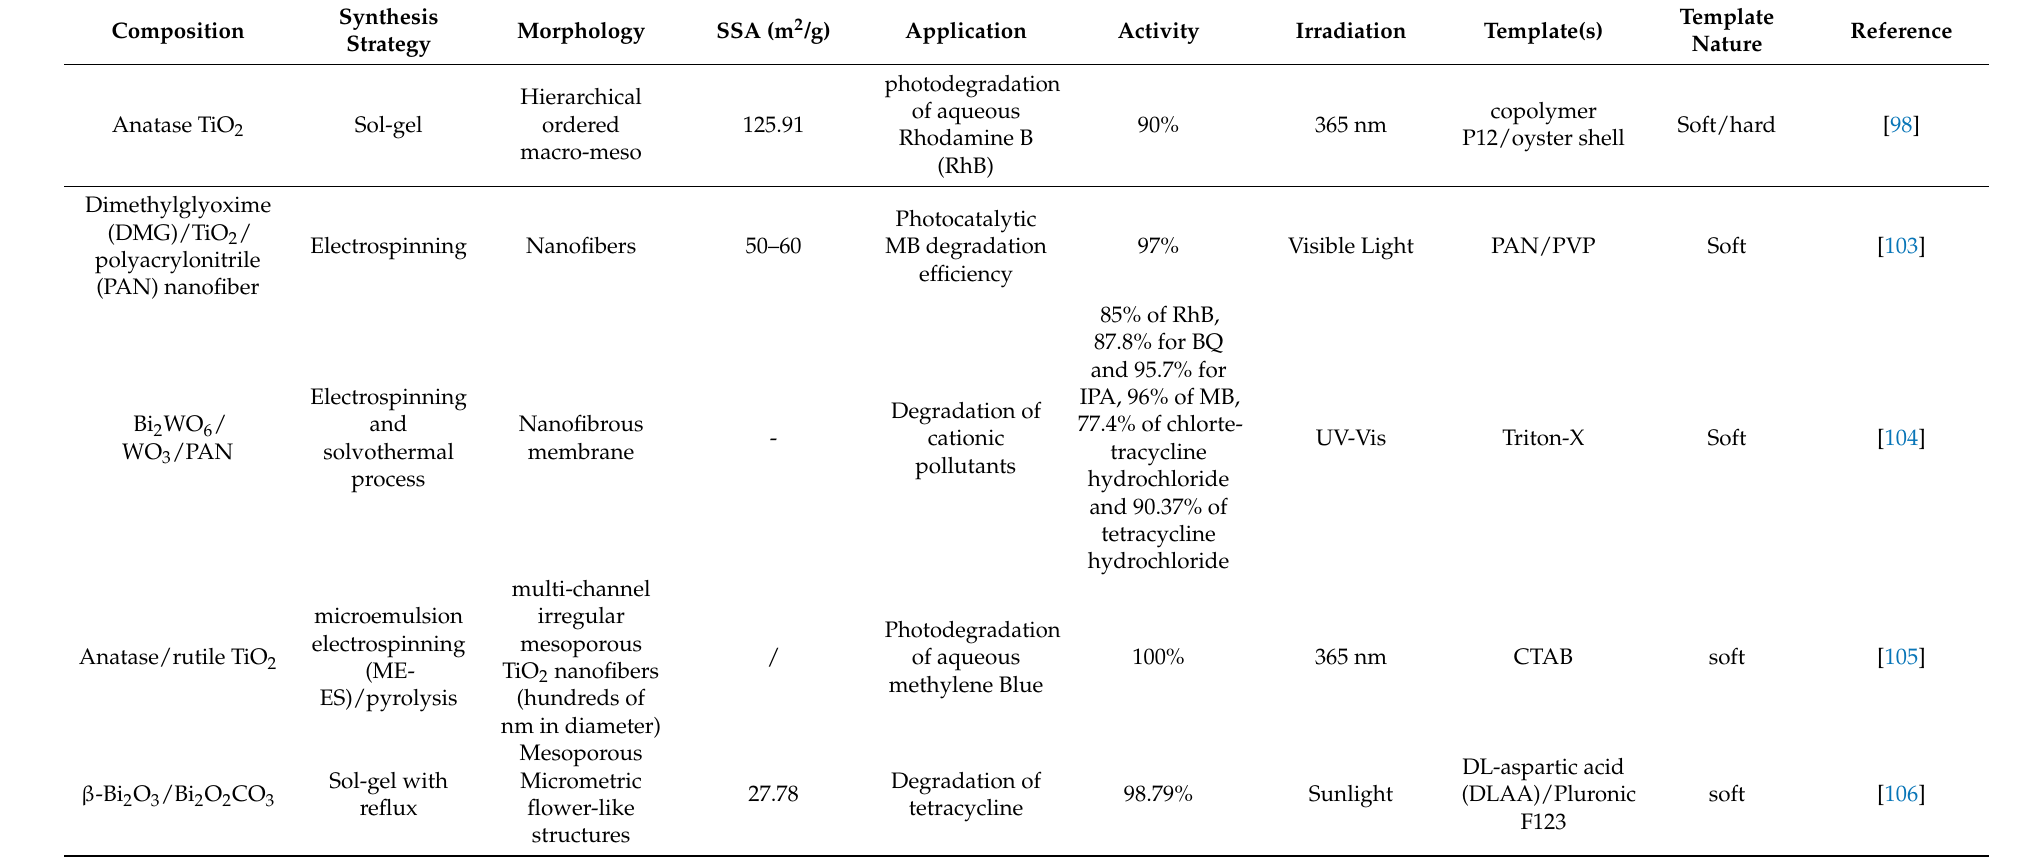
Table 2. Hierarchical catalysts produced by using synthesis